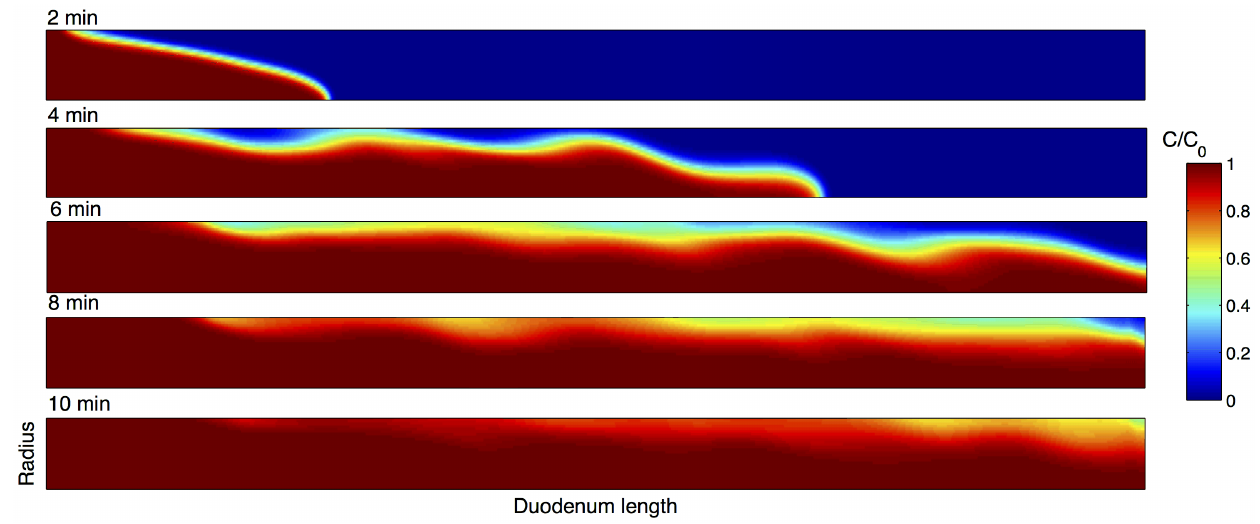
Figure 4. Results from fluid mechanical simulation of the dispersion of the probe in the duodenum of the rat during pendular activity using the CFD model showing the pattern of dispersal 2, 4, 6, 8 and 10 min after the delivery of the step in dye input injection. Pendular activity increased the dispersion in the periphery more than in the center of the lumen. The top boundary is the intestinal wall; the bottom boundary is central luminal axis and the direction of flow is from left to right. The horizontal axis is assumed to be an axis of